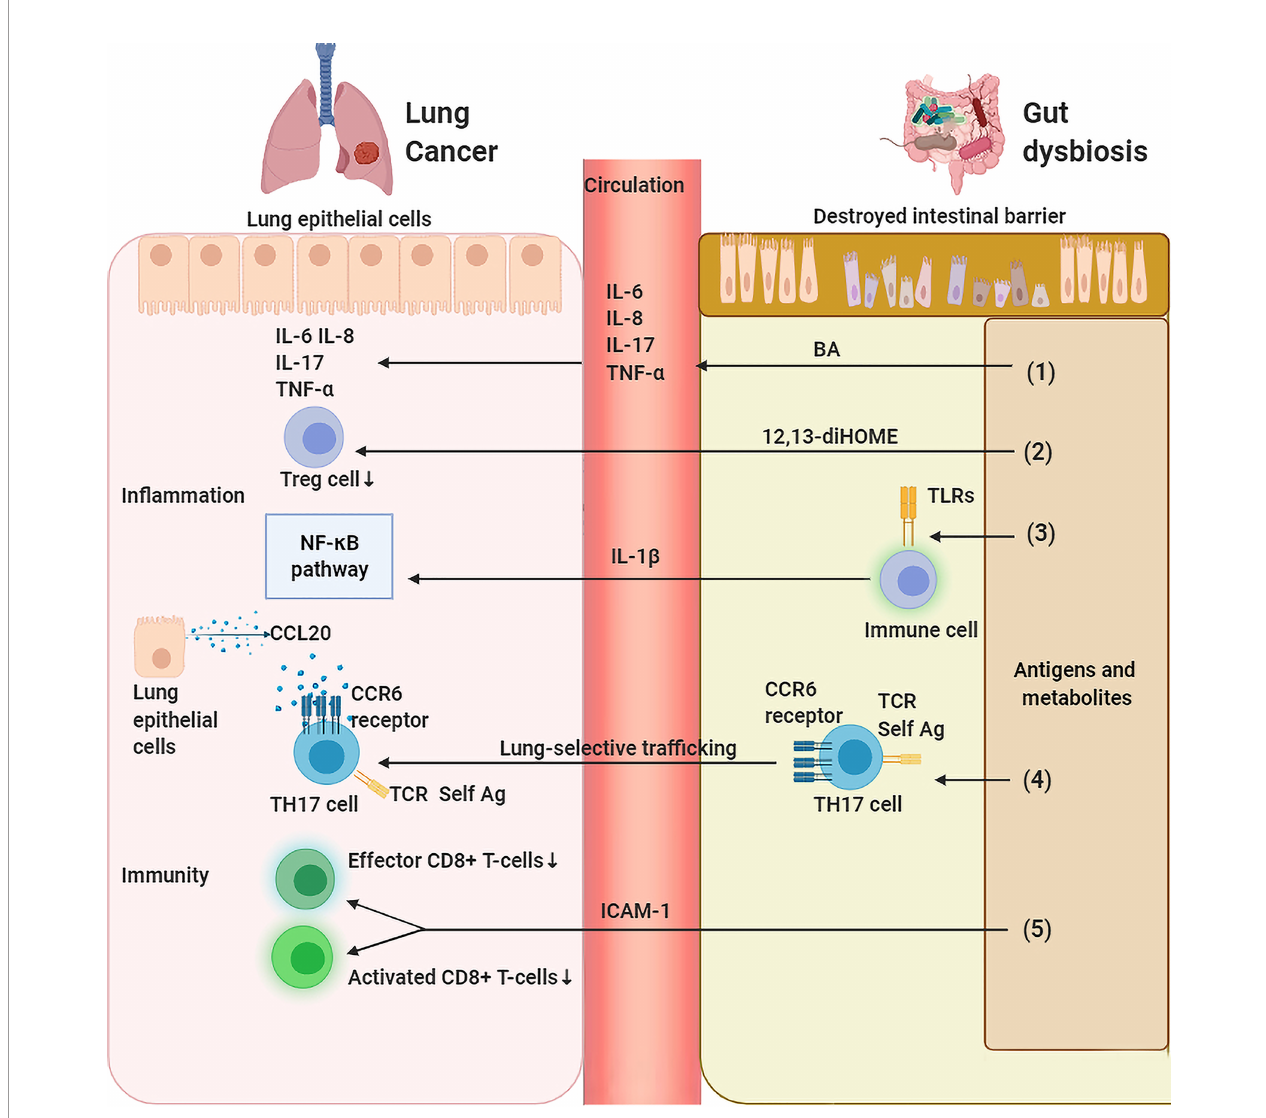
FIGURE 2 | Gut dysbiosis regulates lung in fl ammation and immunity. (1) Gut dysbiosis causes damage to the intestinal mucosal barrier, invading gut bacteria and metabolites affect the host ’ s in fl ammation and immunity locally and systematically which in turn leads to the carcinogensis of lung cancer. Bile acid (BA) stimulates in fl ammatory markers such as IL-1 b 、 IL-6 and IL-8 in the lung. (2) 12,13-diHOME decreases the number of regulatory T (Treg) cells in the lungs resulting in a reduced anti-in fl ammatory effect. (3) Bacteria-derived antigens activates TLR4 in the intestine immune cells, which increases the level of IL-1 b in peripheral circulation that activates NF- k B pathway, leading to pulmonary in fl ammation. (4) SFB-induced gut Th17 cells are preferentially recruited to lung due to robust expression in the lung of CCL20. (5) Gut dysbiosis leads to a decrease in the expression of ICAM-1, which decreases the number of activated and effective CD8+ T cells in